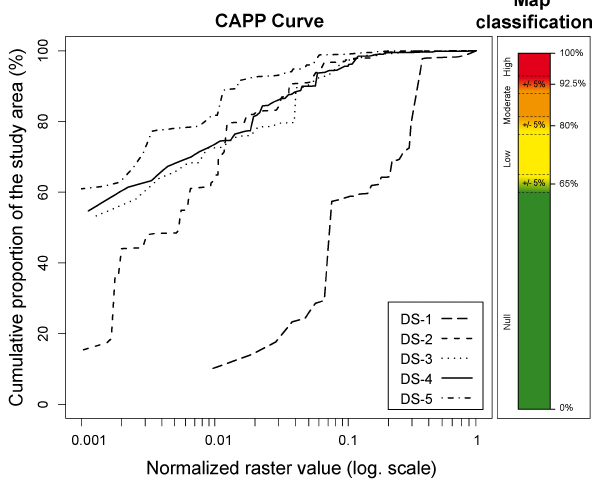
Fig. 9. CAPP curves of the five models displayed using normalised coefficients and value breaks of the final map